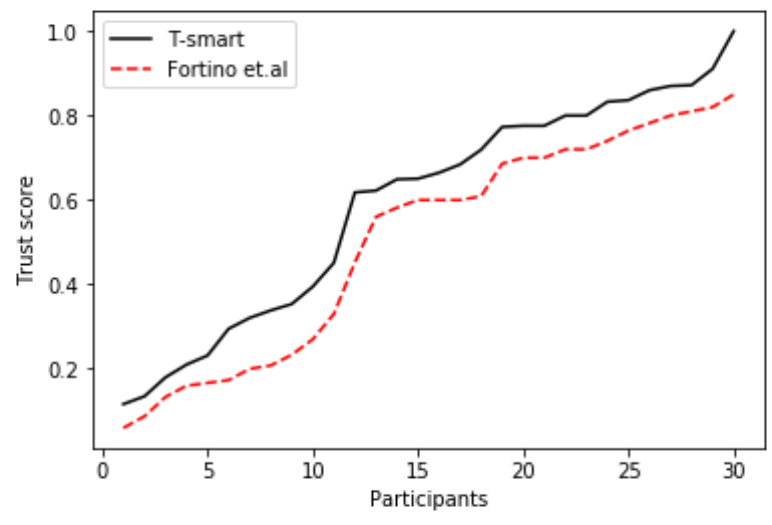
Figure 2. Participants trust value.